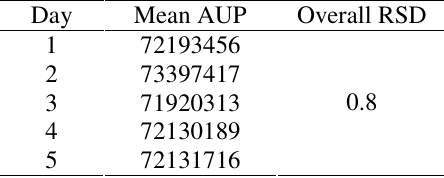
Table 7. Stability of standard insulin preparation (100